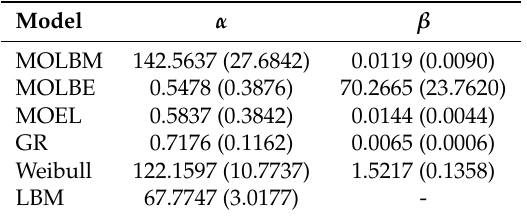
Table 15. Estimates and standard errors (in parentheses) of the parameters for Data set 5.